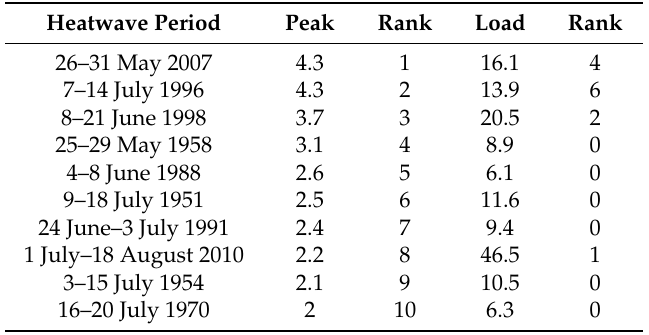
Table 8. Heatwave event peak and load using severity for Moscow (1948 to 2018). Top 10 ranked for event peak severity. Severity is dimensionless [].